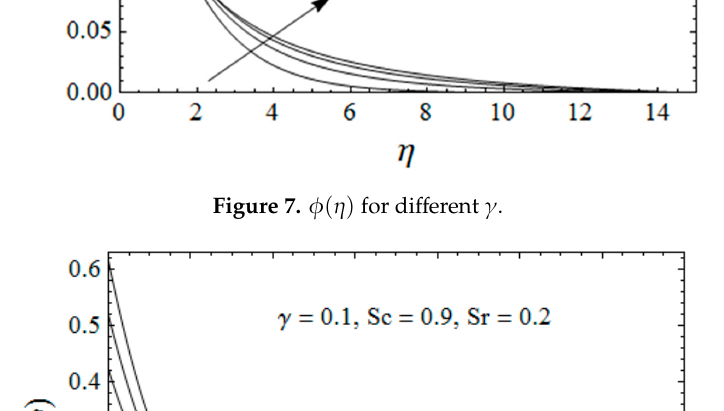
Figure 7. 𝜙(𝜂) for different 𝛾.